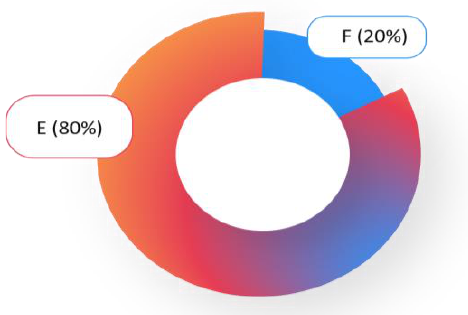
Figure 22. Classification by input data type.